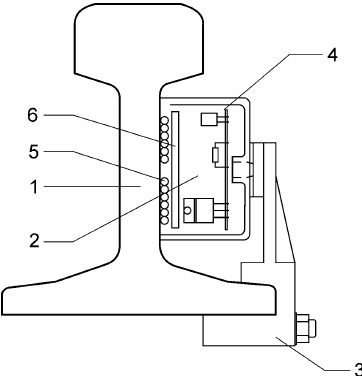
Figure 13. Snow melting device mounted on the stock-rail web; 1: stock-rail web, 2: heater, 3: clamping system, 4: power supply system, 5: inductor, and 6: protective plate [20].